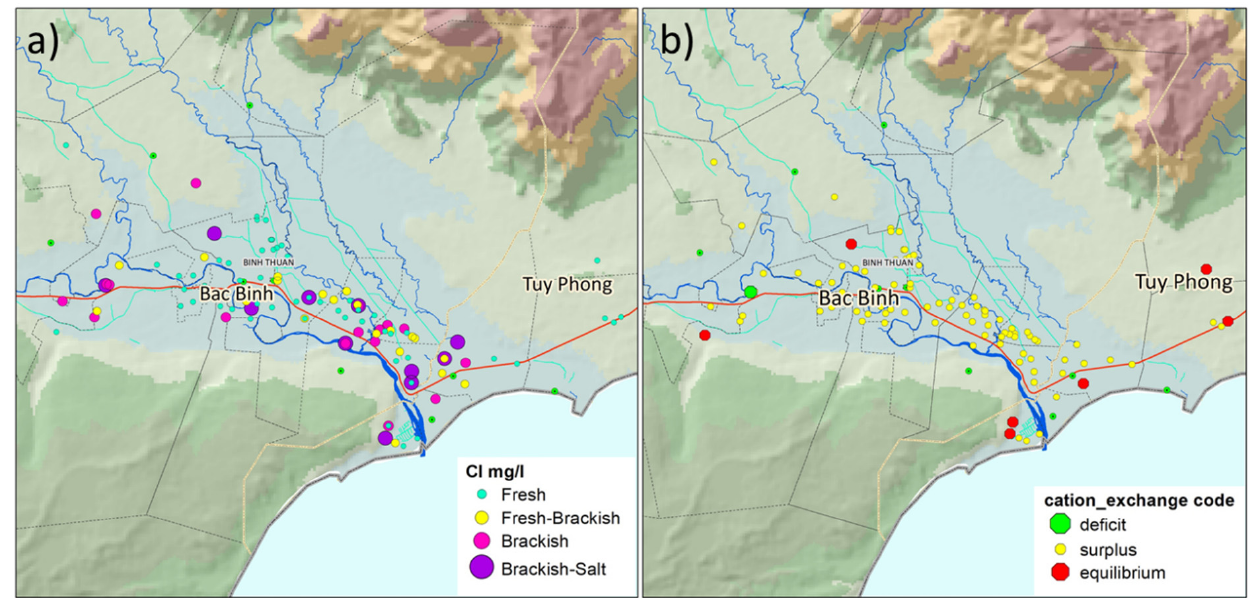
Figure 5. ( a ) Water type distribution based on the Cl − content and ( b ) the distribution of cation exchange code of water samples in the Luy river catchment.